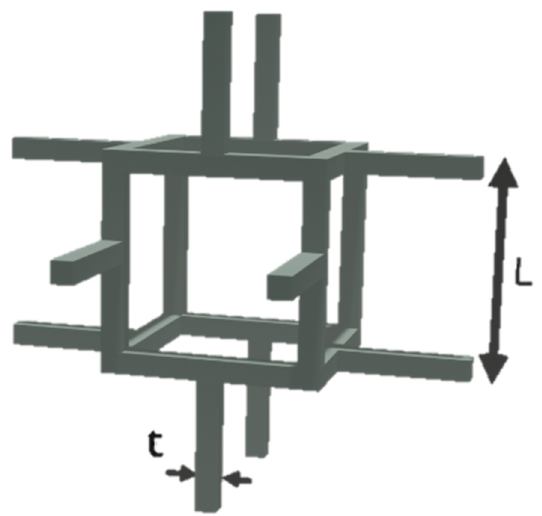
Figure 4. Unit cell model of a cellular porous material, Adapted from [24].